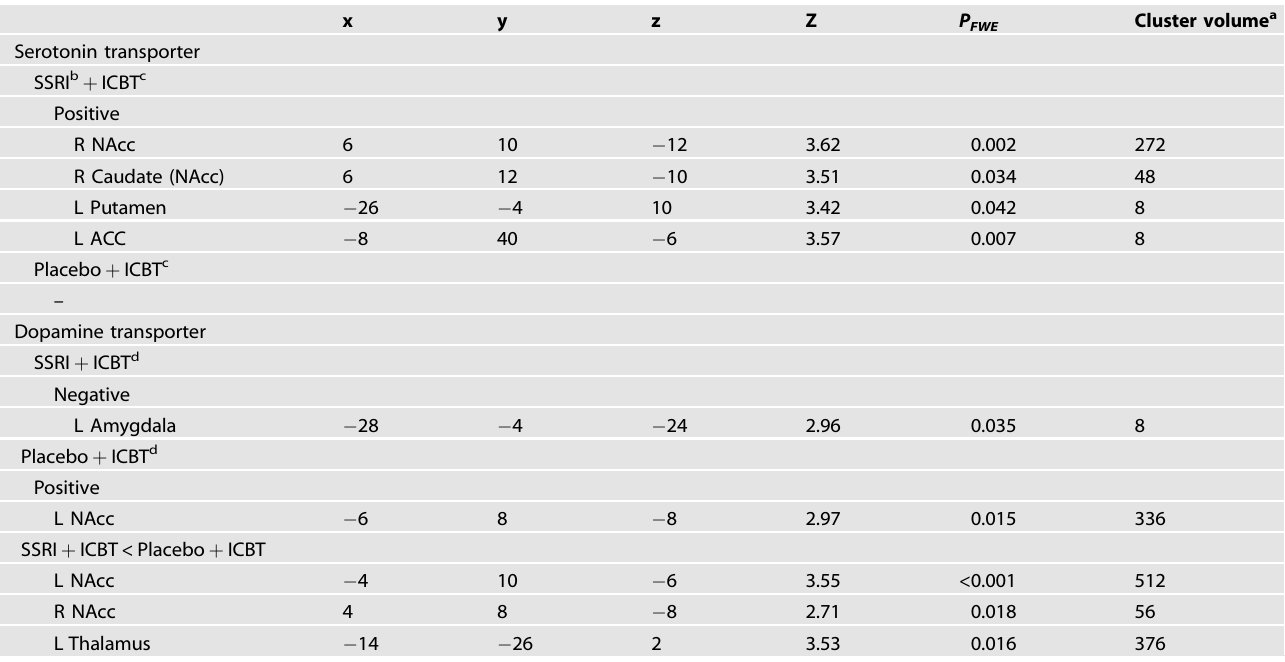
Table 3. Relations between treatment-induced changes in symptom severity, as measured by the Liebowitz social anxiety scale (LSAS), and corresponding changes in serotonin transporter (SERT) occupancy and dopamine (DAT) transporter binding potential (BP ND